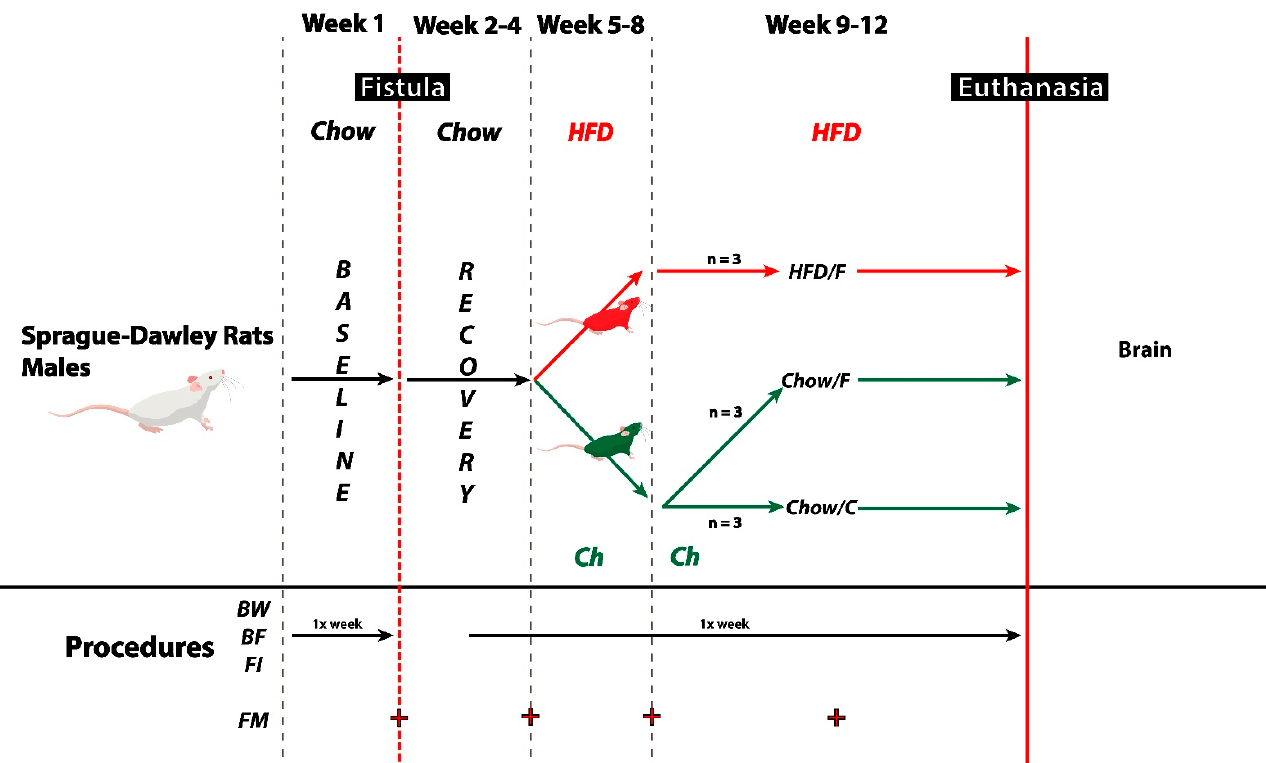
Figure 3. Experimental timeline. Following a ten-day acclimation period, male Sprague-Dawley rats ( n = 9) underwent the fistula implantation surgery. After three weeks of recovery, animals were randomly assigned to following groups: HFD/F ( n = 3), Chow/C ( n = 3), and Chow/F ( n = 3). The HFD/F group was switched to a high-fat/high sugar diet. The other two groups remained on regular chow. During the last four weeks of the experiment, the HFD/F and Chow/F groups were restrained using a plastic decapicone three times per week, their fistulas were opened, and gut contents were removed using a 3 mL plastic pipette. Throughout the experiment, body weight, body fat mass, and 24-h food intake measurements were recorded once a week.